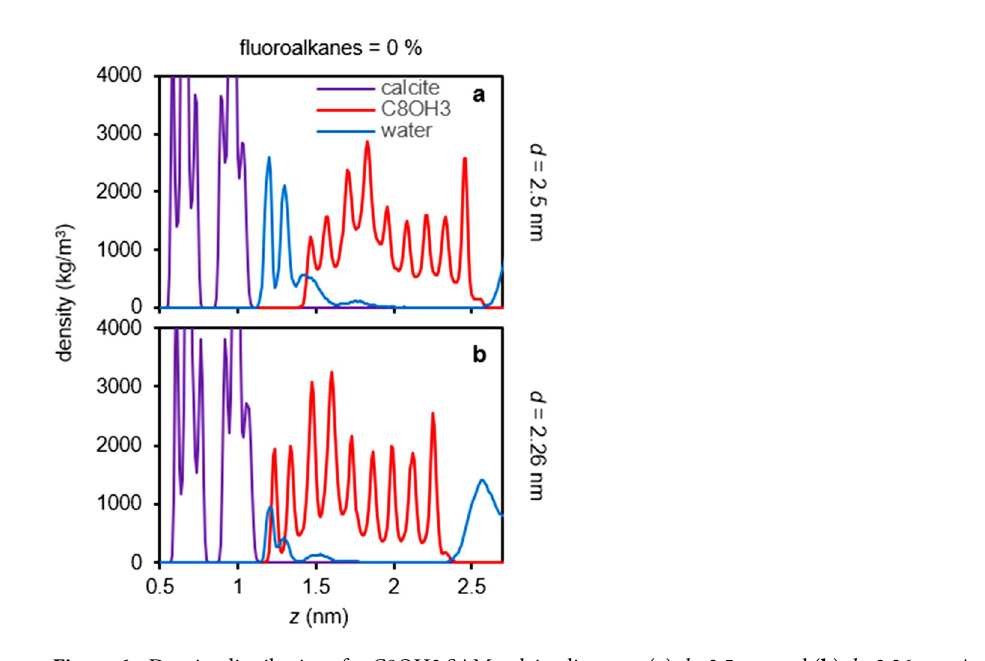
Figure 6. Density distributions for C8OH3 SAM-calcite distances ( a ) d = 2.5 nm and ( b ) d = 2.26 nm. At d = 2.5 nm, the hydroxy groups on C8OH3 can participate in the third hydration layer. At d = 2.26 nm, the hydroxy groups on C8OH3 can participate in both the first and second hydration